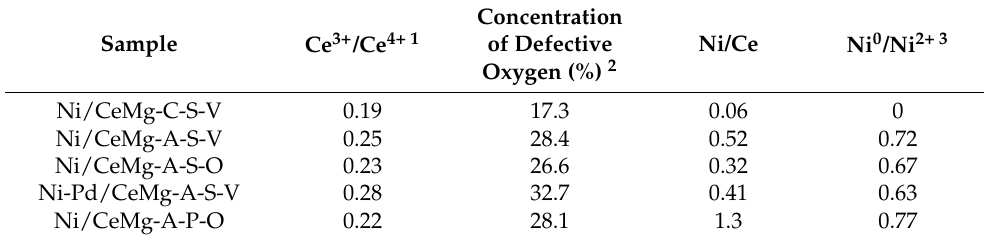
Table 4. XPS results of catalysts.